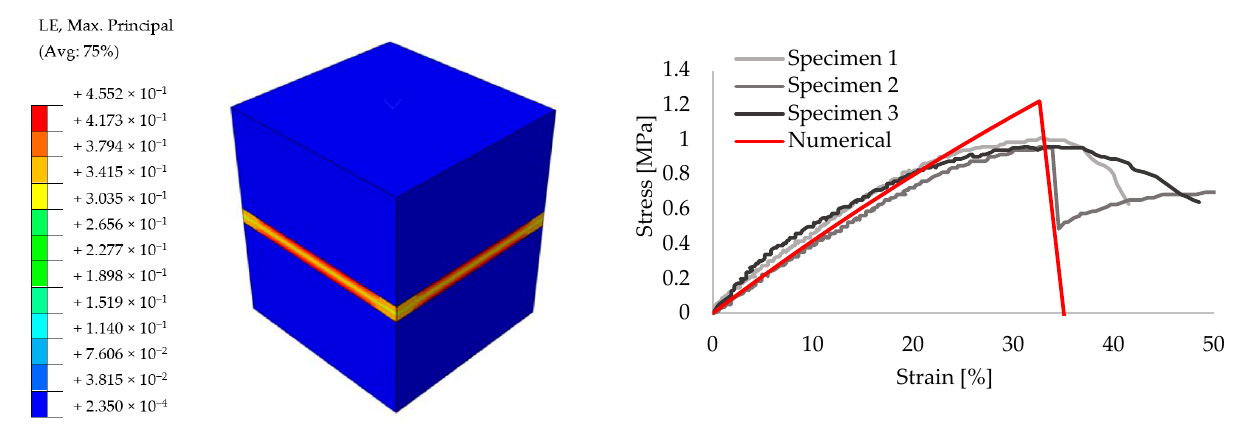
Figure 12. Tension results for the small size specimens with mortar: true strain diagram ( left ) and comparison of the